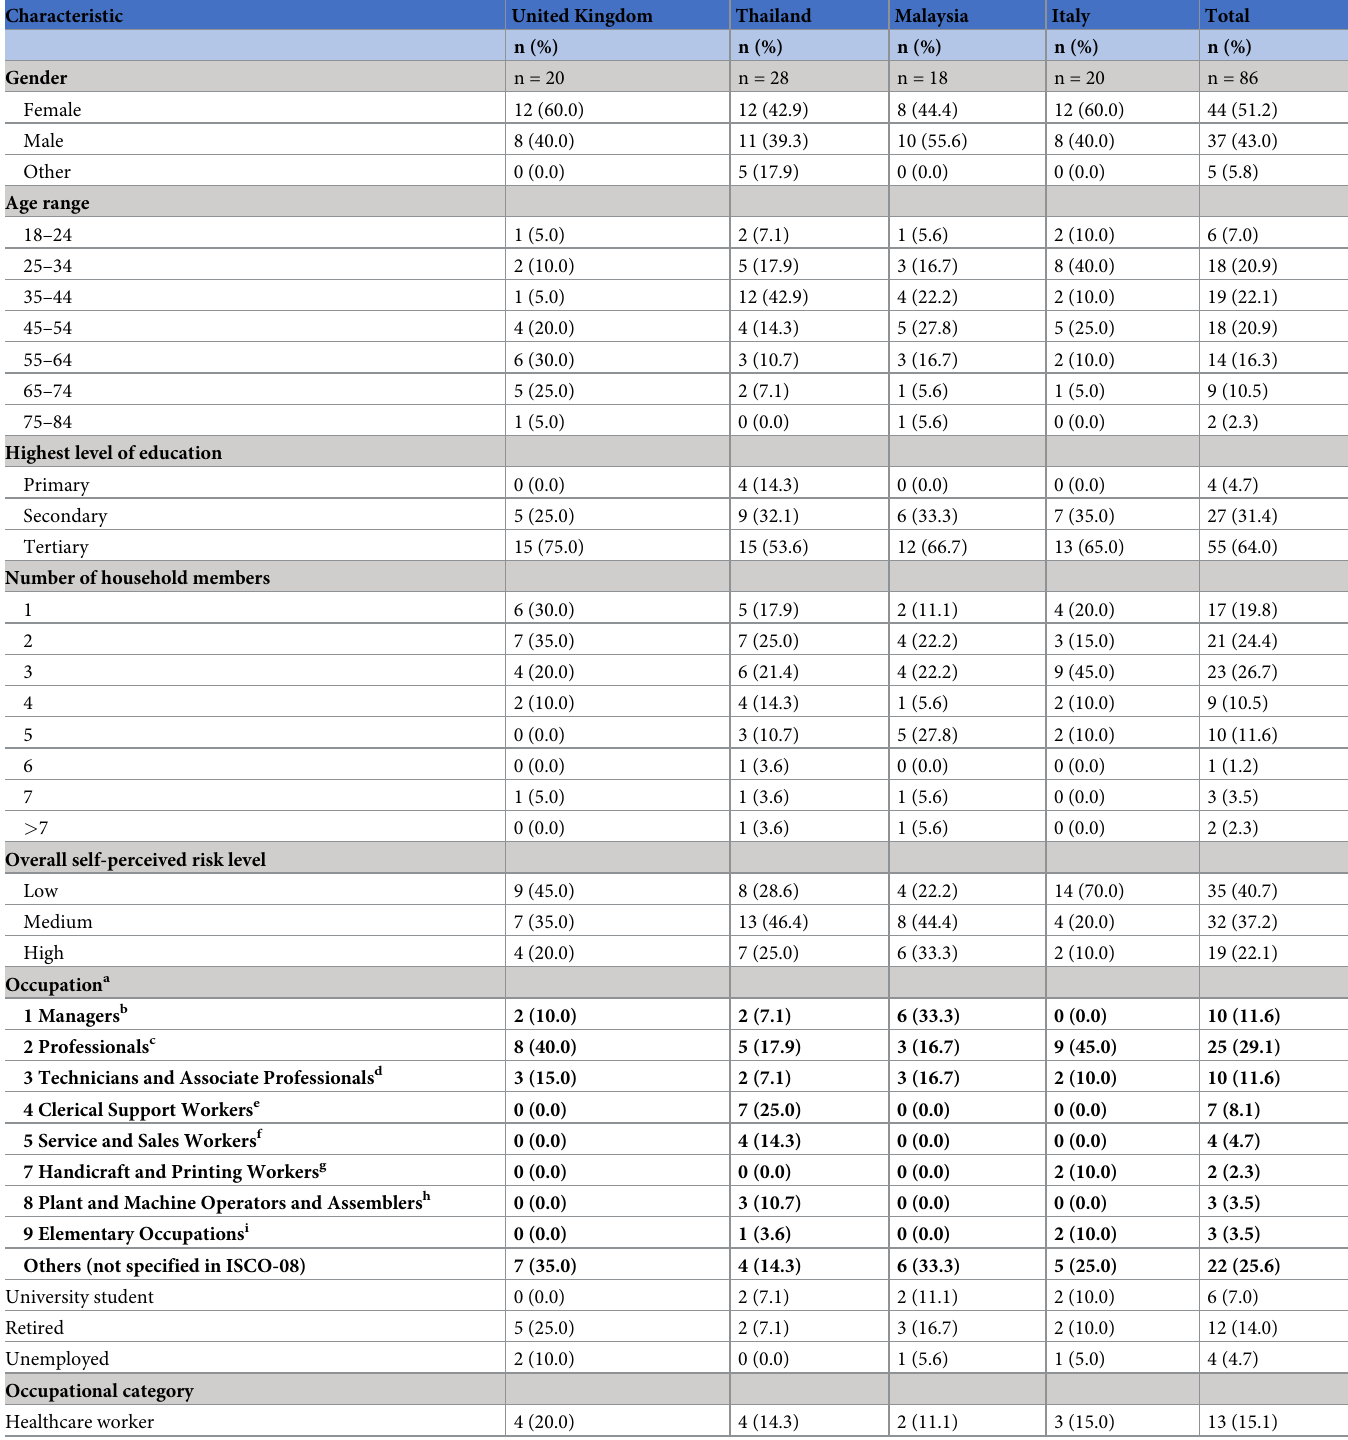
Table 1. Participant